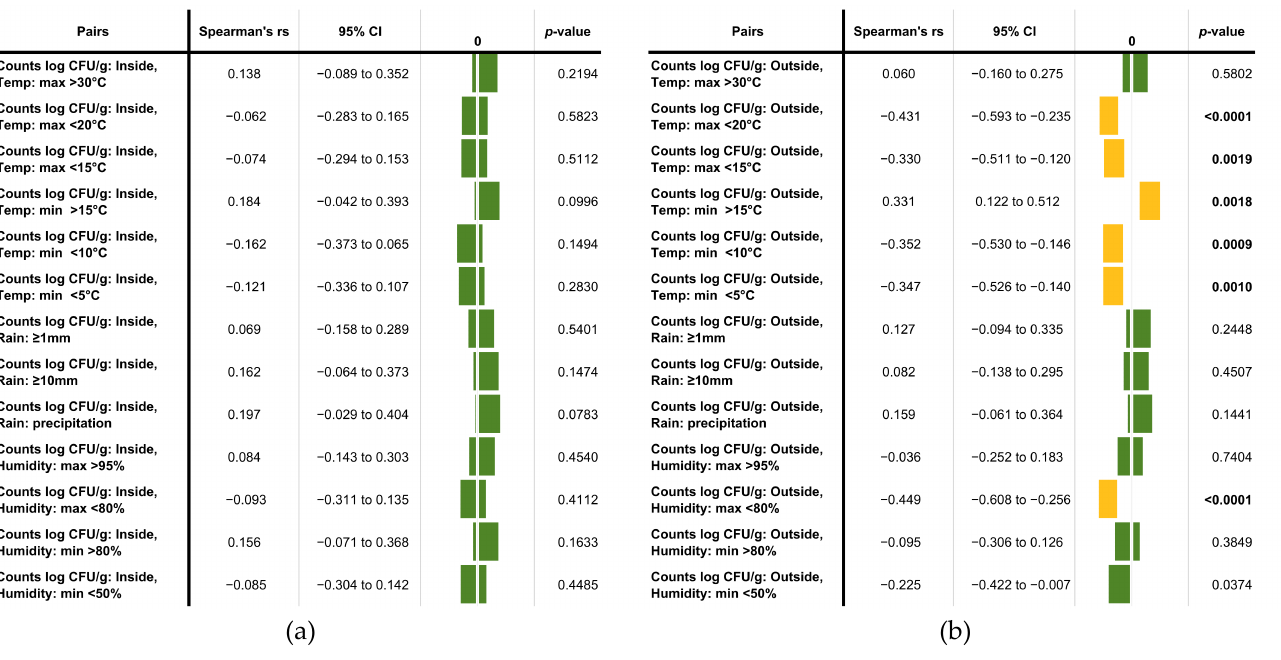
Figure 4. Correlation analysis between average viable Basidiobolus spp. counts and selected cli- mate data for: ( a ) Gecko droppings collected indoors and ( b ) gecko droppings collected outdoors. Statistically significant correlations are highlighted in yellow with p -values marked in